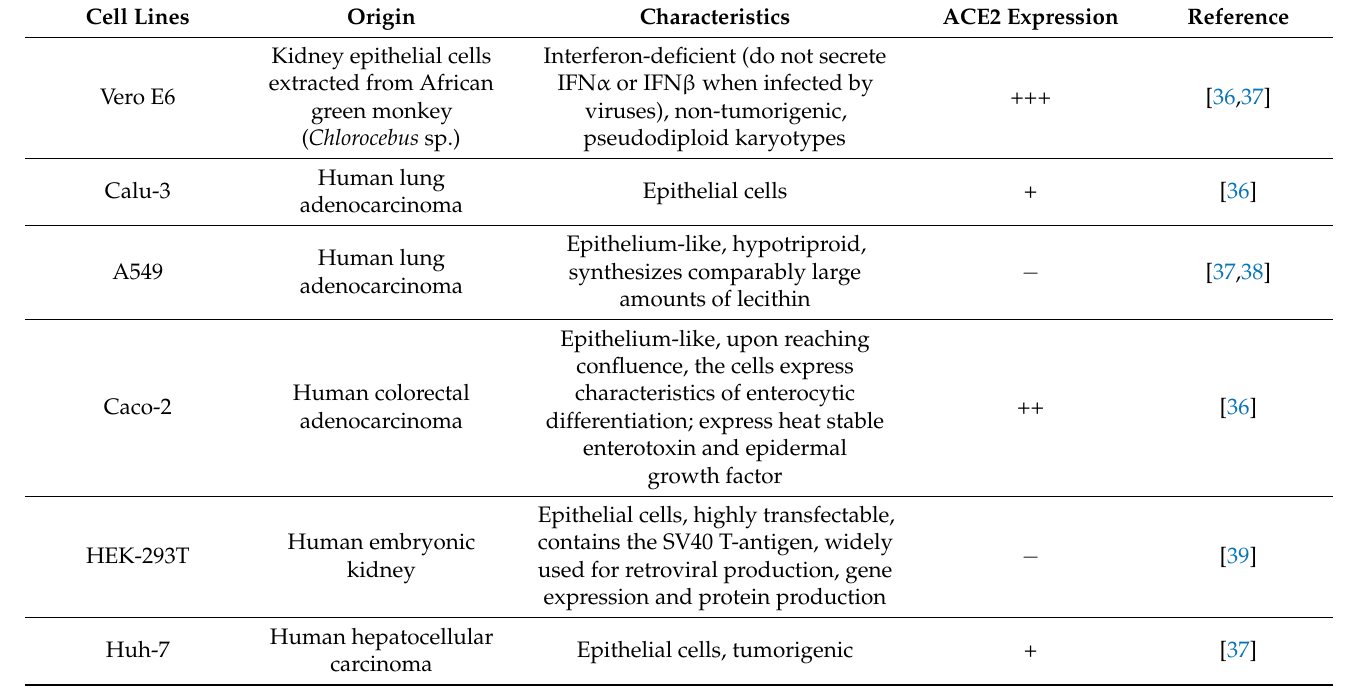
Table 1. Overview of cell lines most commonly used to study